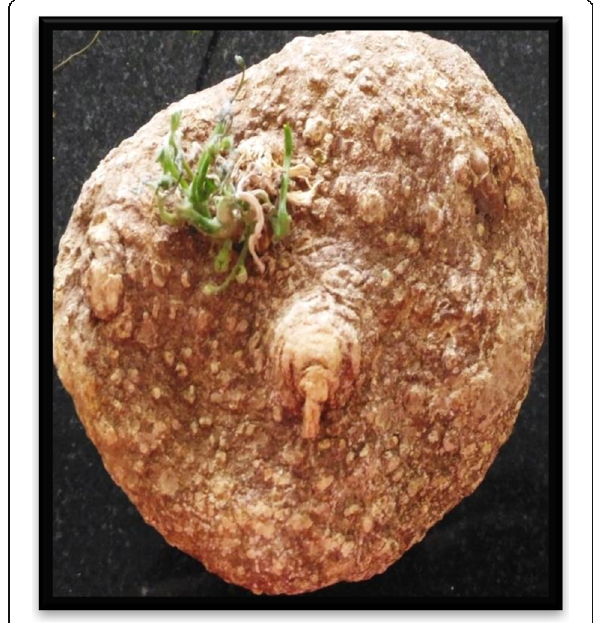
Fig. 1 Tuber of Corallocarpus epigaeus (Arn.)